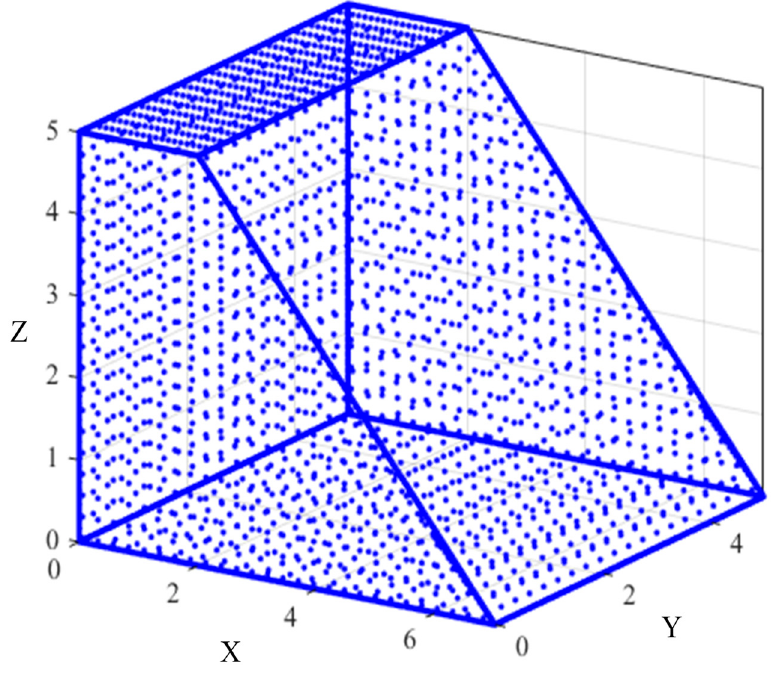
Figure 14. Flow through a trapezoidal dam in three dimensions.